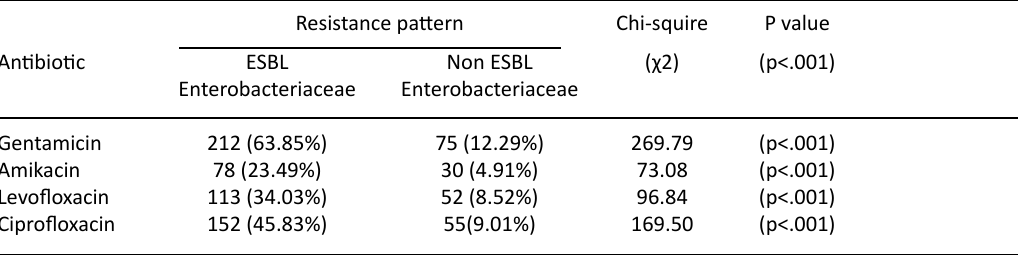
Table 5. ESBL gene detection in Enterobacteriaceae isolates ESBL isolates